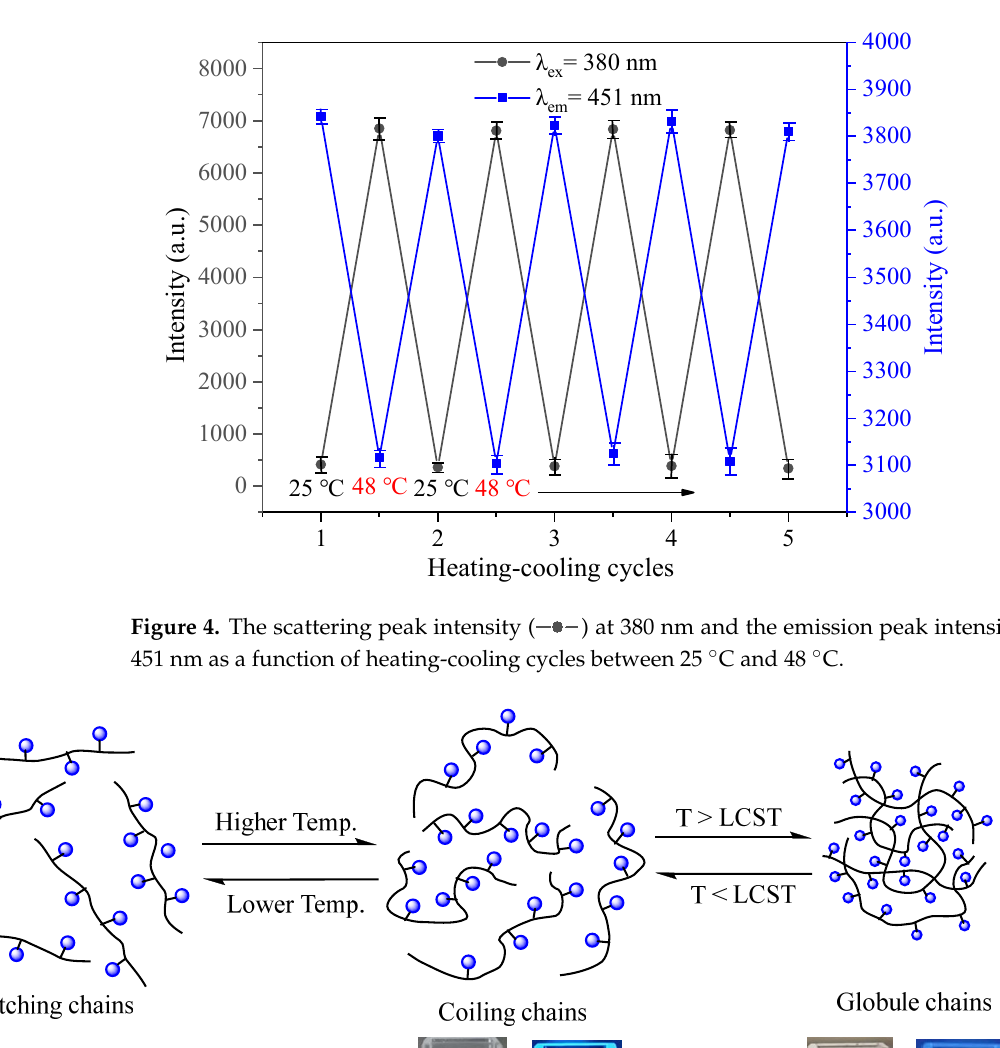
Scheme 2. The mechanism of PL intensity variations of poly-N-CQDs to thermo-responsiveness.